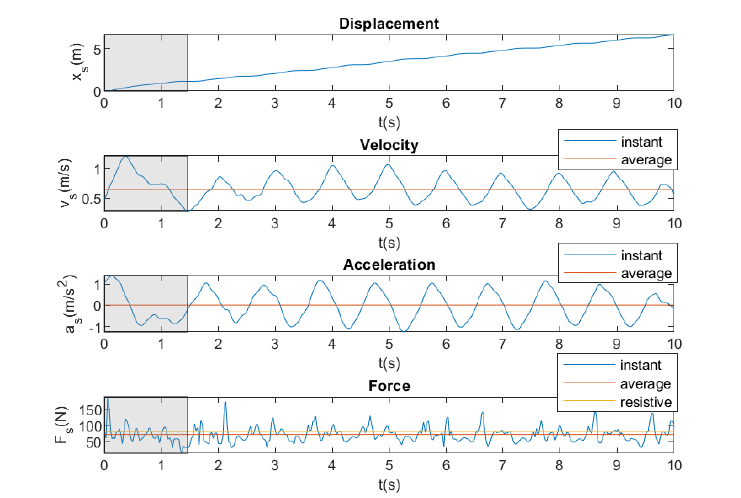
Figure 12. Instantaneous and average displacement, velocity, acceleration and force. Breaststroke. Brake force = 81.58